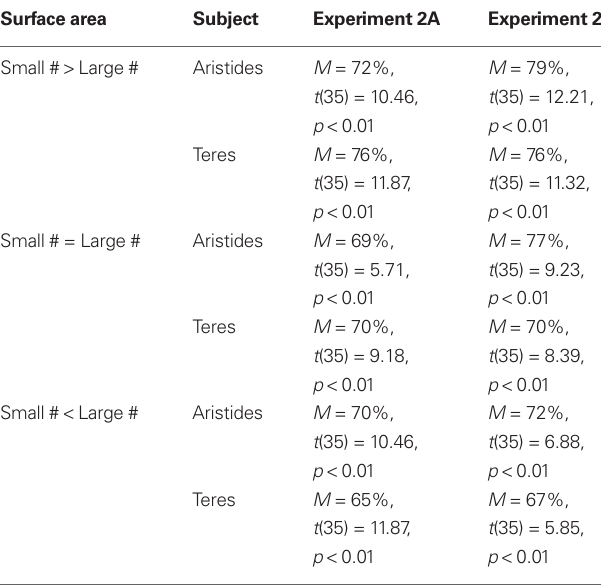
Figure 6 | Average accuracy for experiment 2A as a function of the ratio of the numerical values being compared. The dotted line indicates chance for the